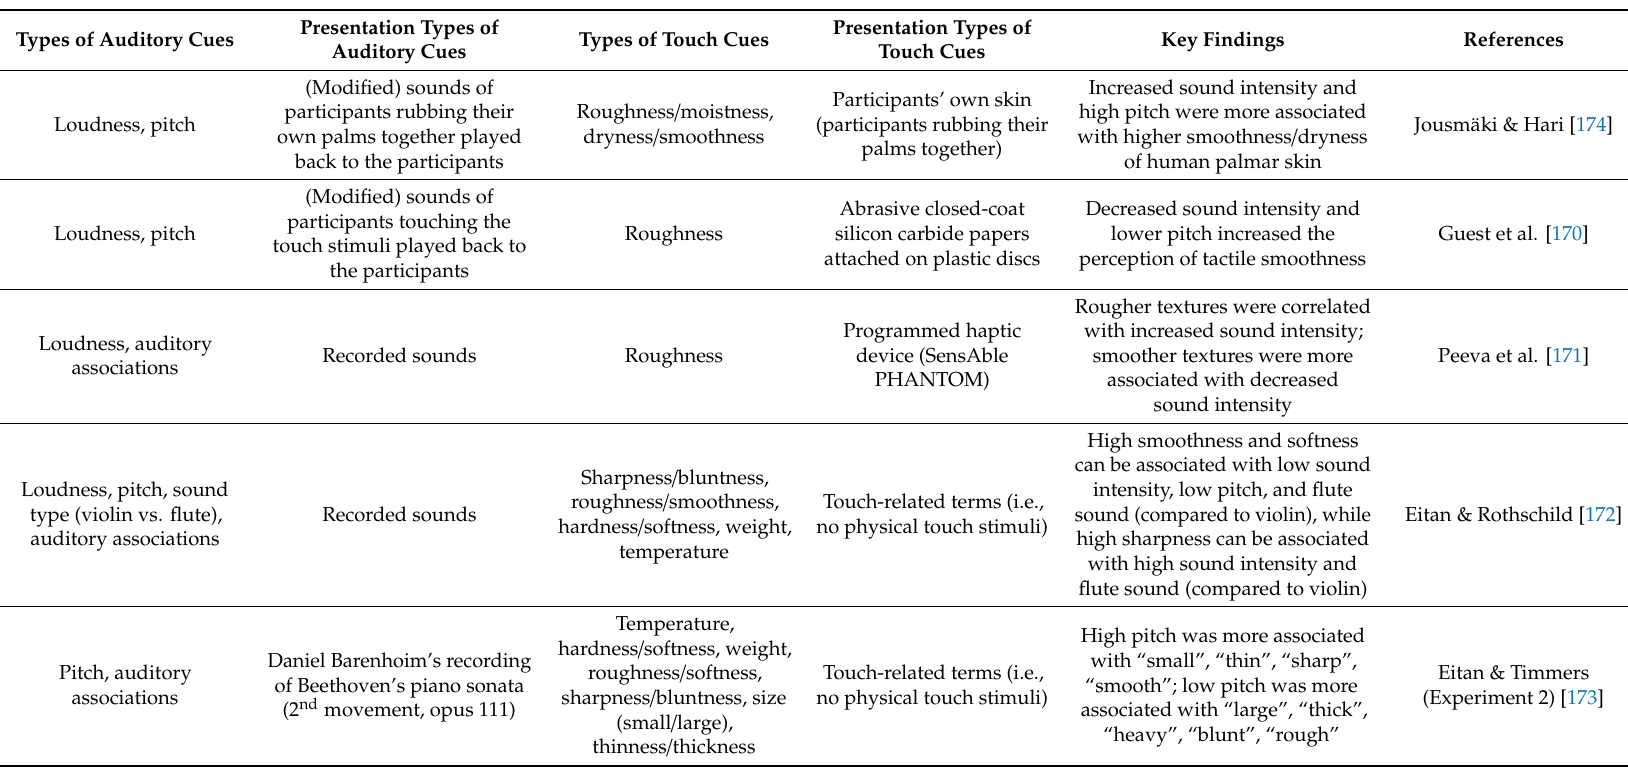
Table 2. The summary of findings regarding cross-modal associations between auditory and hand-feel touch